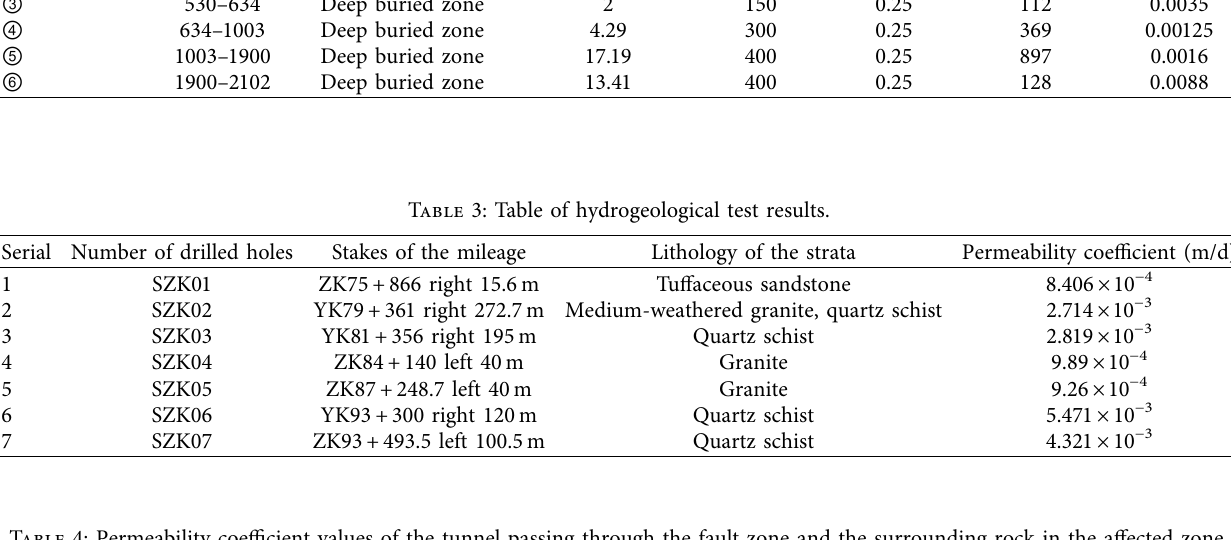
Table 3: Table of hydrogeological test results.